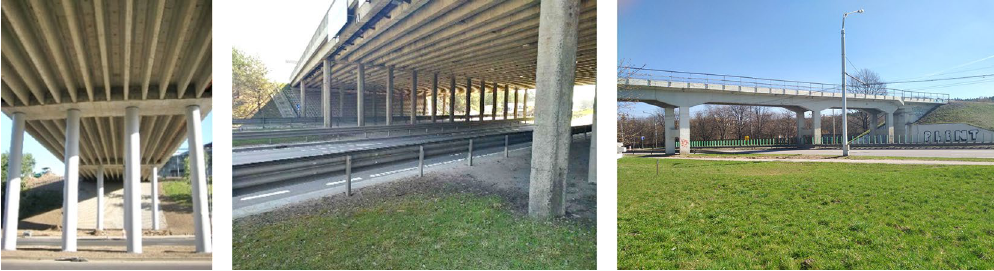
Fig. 2. The transport industry structures operating in highly aggressive media